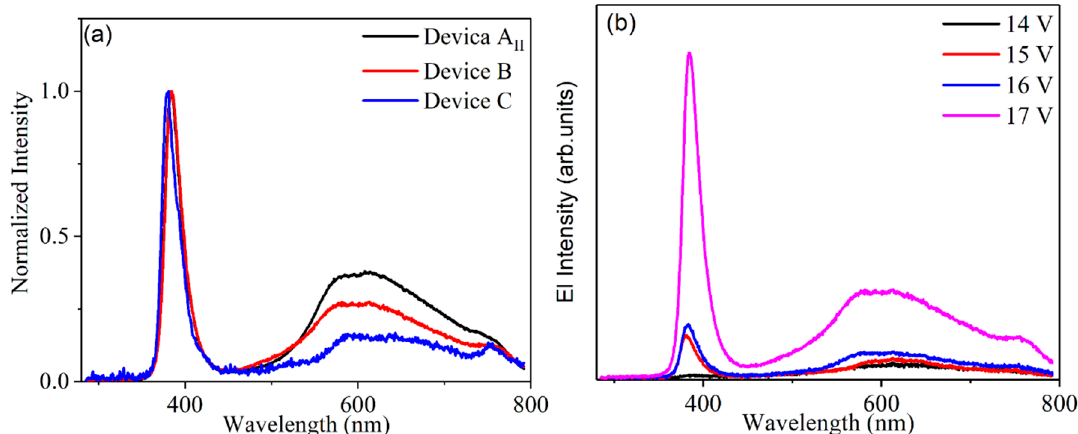
Figure 4. EL spectra of the three devices ( a ) and Device B under different biases ( b ).